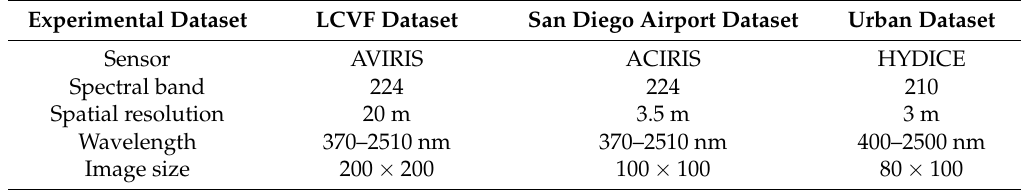
Table 2. Details of the experimental images acquired from different sensors. Experimental